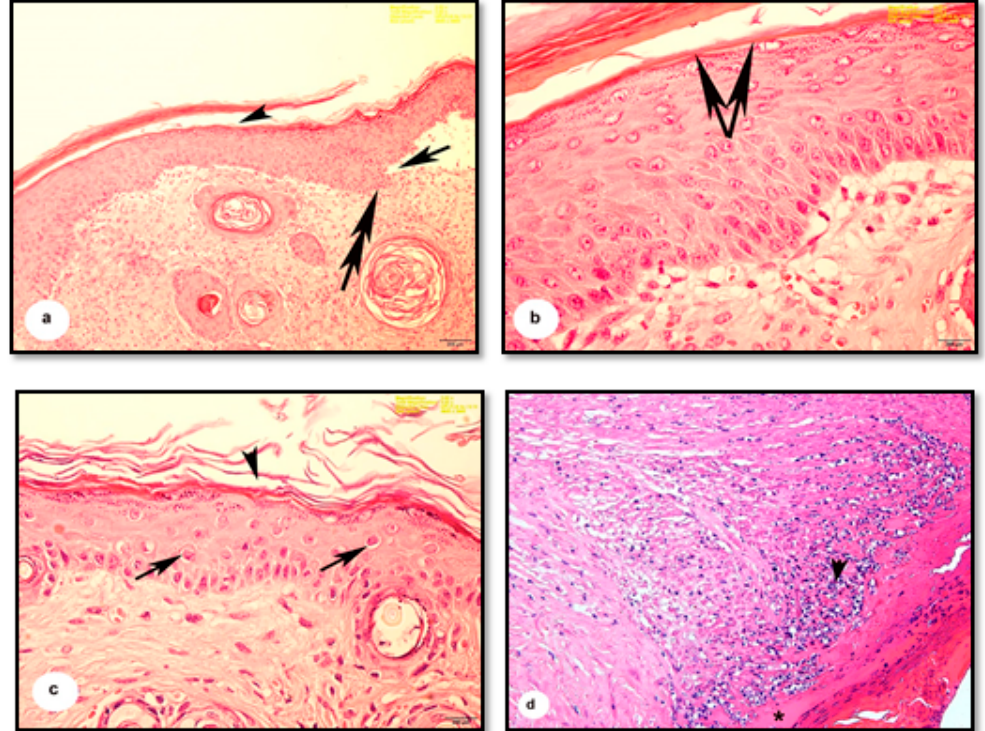
Figure 4. Photomicrographs of sections of burnt wounds treated by HCl 80% of the mice’s skin. ( a ) Showing distortion of the keratinized layer of the epidermis (arrowhead). Slight separation of the epidermis from the dermal layer at specific points (arrow) and discontinuous basement membrane (double-head arrow). ( b ) Showing thickening of the epidermis and termination of the horny layer from the epidermis (arrows). ( c ) Showing cytoplasmic degeneration of some epithelial cells (arrows). Severe disintegration and fragmentation of the horny layer (arrowhead). ( d ) Showing invasion of inflammatory cells in the dermal layer (arrowhead) and eosinophilic region (*). (H & E, scale bar: a = 100 µ m, b = 400 µ m, c = 400 µ m, d: Magnification: 2.52 ×